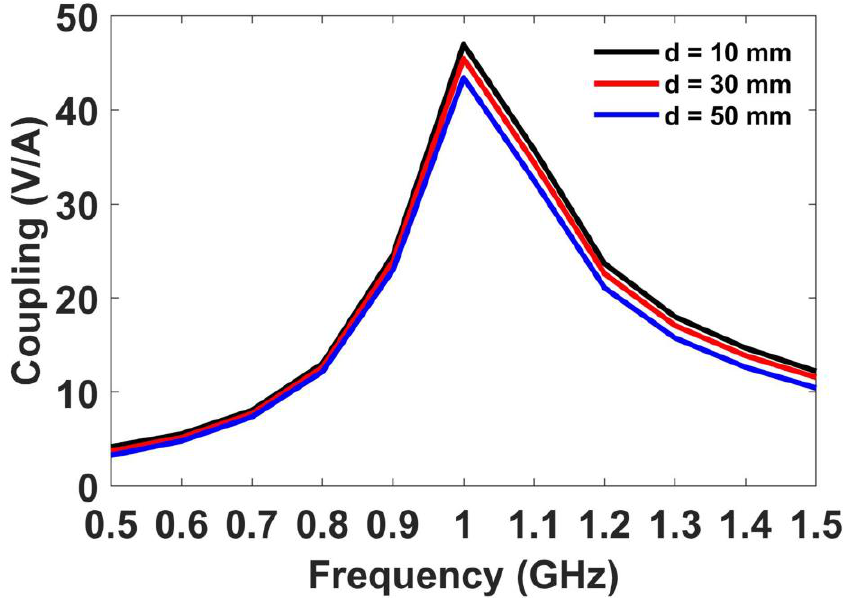
Figure 5. Coupling performance by rectangle #1 versus frequency.